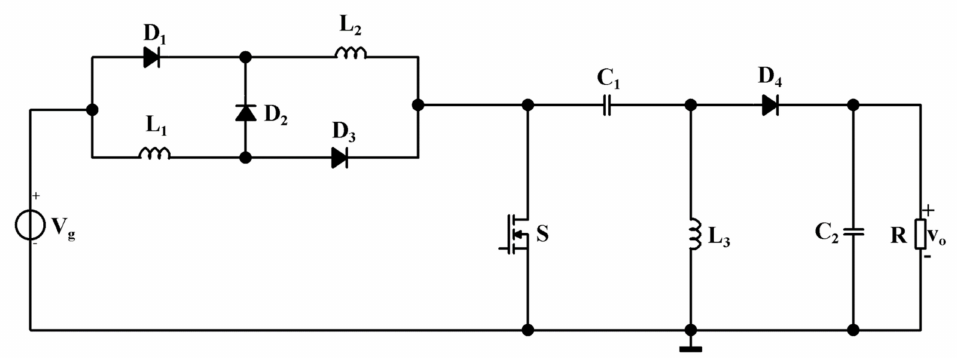
Figure 1. SEPIC hybrid converter with a switching Up 3 structure presented in